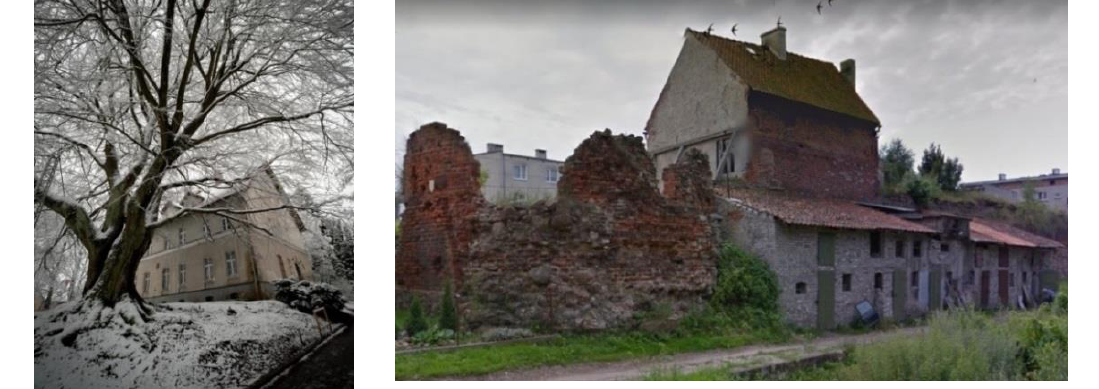
Figure 3. Object 1 an object 2 (source: photographed Anna